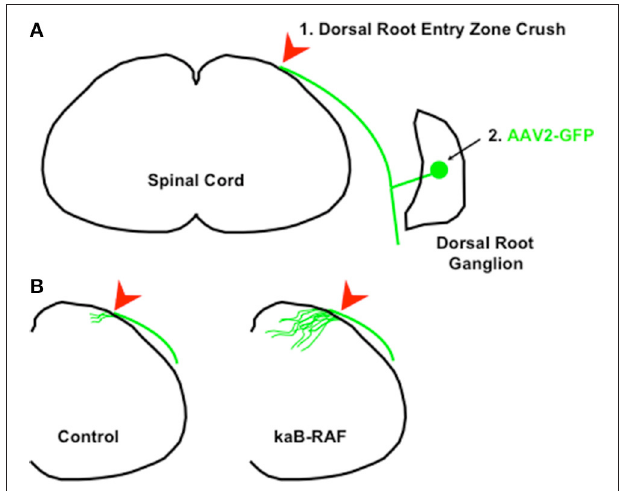
FIGURE 3 | Constitutive B-RAF drives dorsal root entry zone regeneration. (A) 1. The dorsal root is crushed at the dorsal root entry zone. 2. To visualize dorsal root ganglion neurons, AAV2-GFP is injected into either adult control mice or adult kaB-RAF-expressing mice. (B) Two weeks following crush, the processed tissue reveals robust regeneration into the spinal cord in B-RAF-expressing mice (right) but not in control mice (left). The figure is based on data presented previously ( O’Donovan et al.,